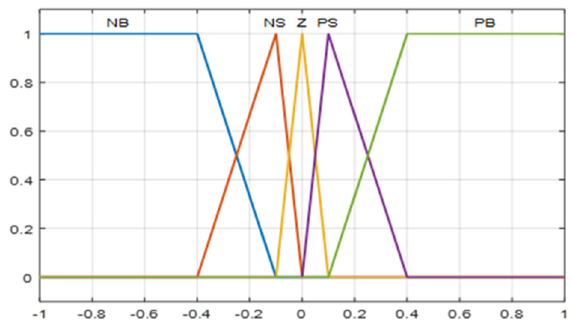
Figure 4. Membership functions of the two inputs and output.